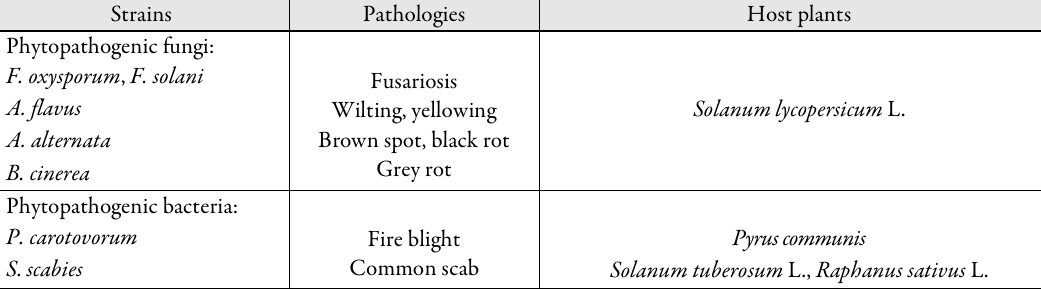
Table 1. Origins and plants diseases of pathogenic fungi and bacteria Pathologies Host